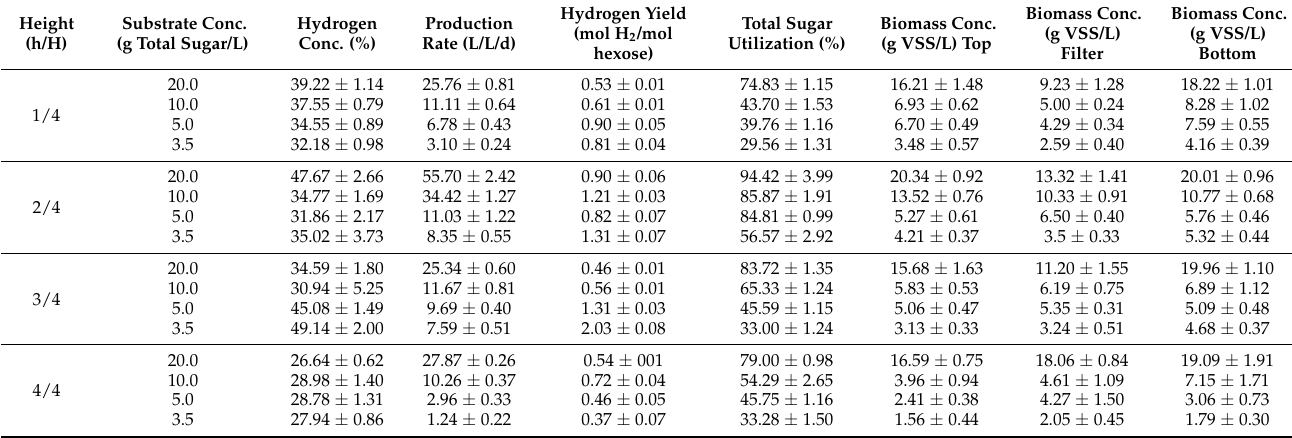
Table 3. Hydrogen production performance and biomass concentrations in the bioreactor at different packed-filter positions and feeding substrate concentrations with HRT 1 h. Height Substrate Conc. (h/H) (g Total